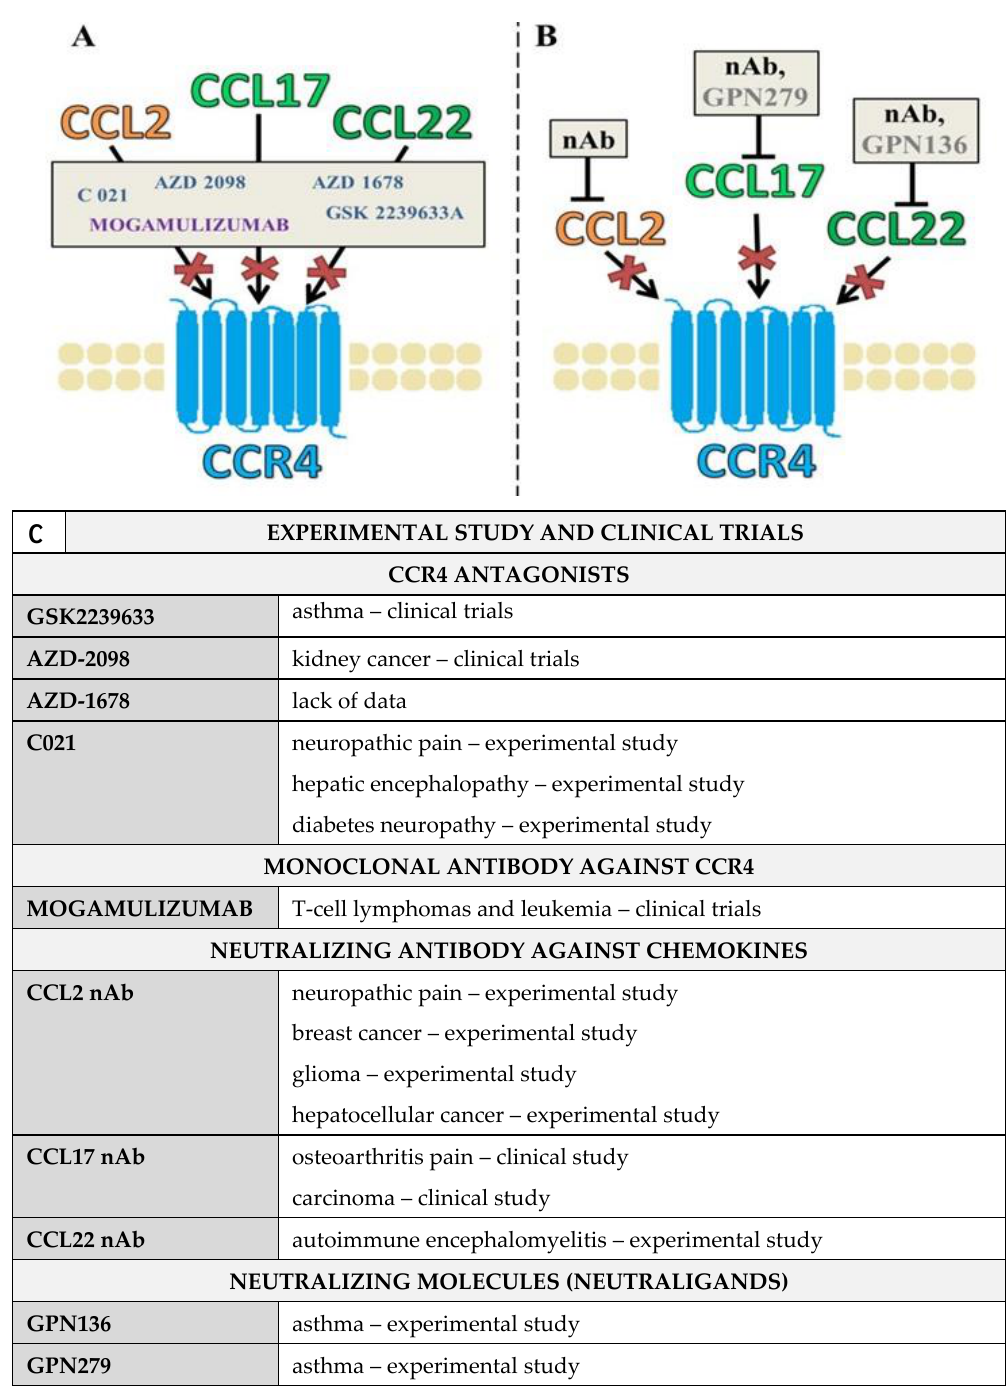
Figure 3. CCR4 as a possible new target for therapy-available pharmacological tools for study. ( A ) blockade of the CCR4 by its antagonists (AZD-2098 [98], AZD-1678 [98]; C021 [33 – 35,42]; GSK 2239633 [41,93]) and by monoclonal antibodies against CCR4 (mogamulizumab [37,38,100 – 102]); ( B ) neutralization of CCR4 ligands by antibodies (CCL2 [104,107 – 109], CCL17 [105,110,111], CCL22 [106]) and using neutralizing molecules of its ligands (GPN279 — target CCL17 and GPN136 -target CCL22 [103]). ( C ) the table summing the experimental study and clinical trials. Abbreviations: chemokine receptor 4 — CCR4; chemokine (C-C motif) ligand 22 (CCL2); chemokine (C-C motif) ligand 17 (CCL17); chemokine (C-C motif) ligand 22 (CCL22); neutralization antibodies (nAb).